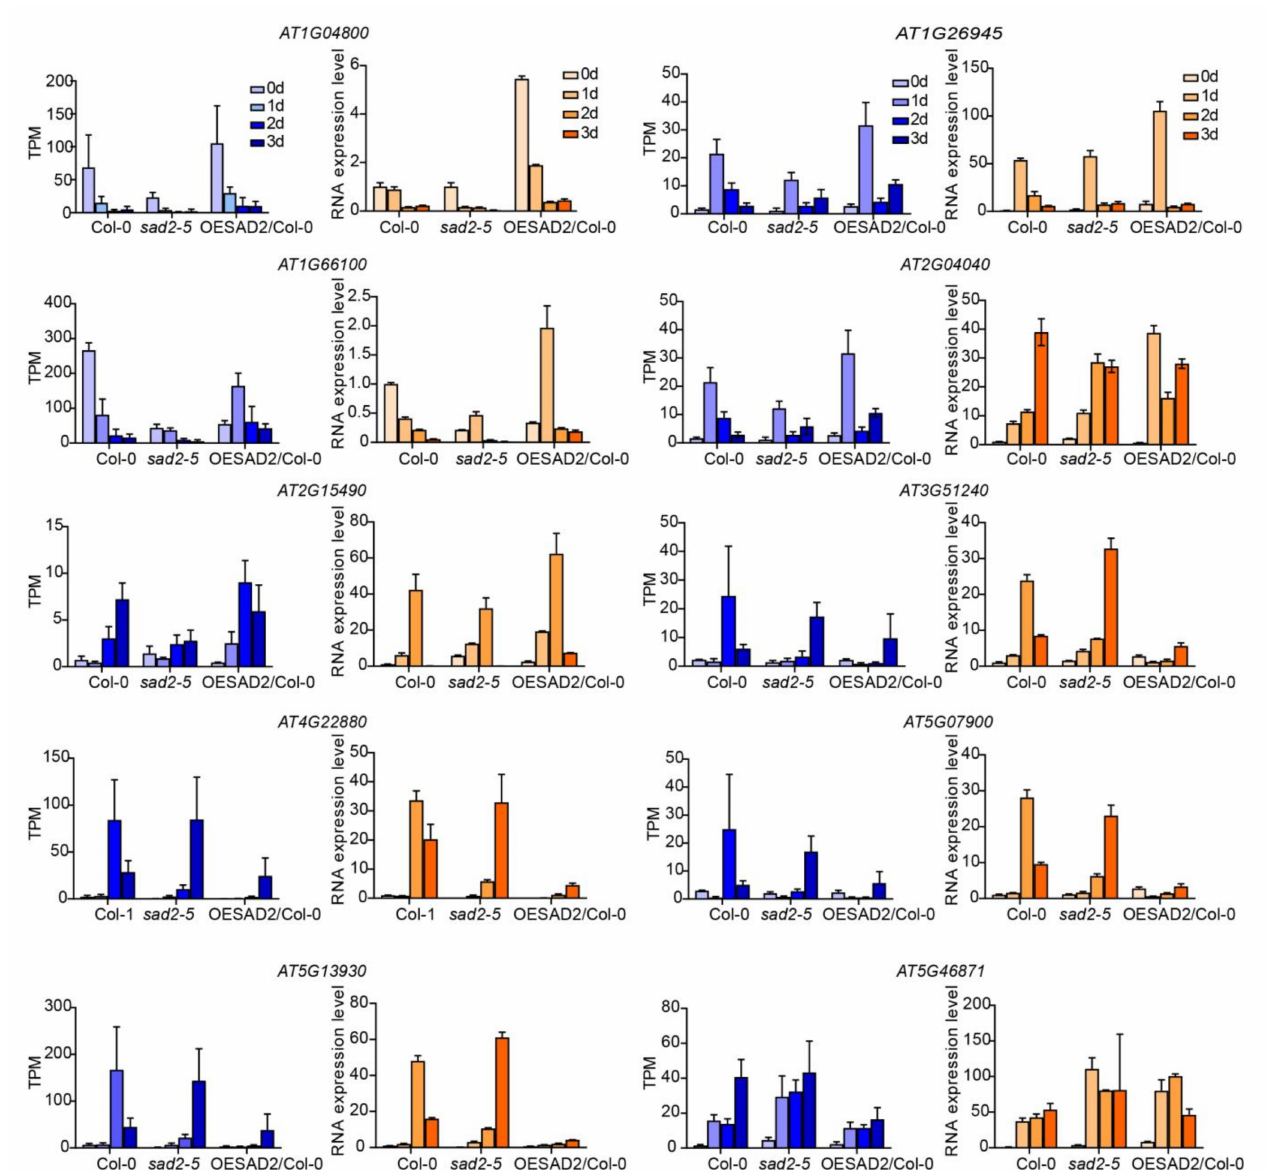
Figure 6. Verification of transcriptome sequencing results via RT-qPCR. The data were normalized by using ACTIN1 (AT2G37620) as an internal reference. Data are represented as mean ± SD for three biological replicates. The TPM values of RNA-seq are shown in blue, and RT-qPCR results are shown in